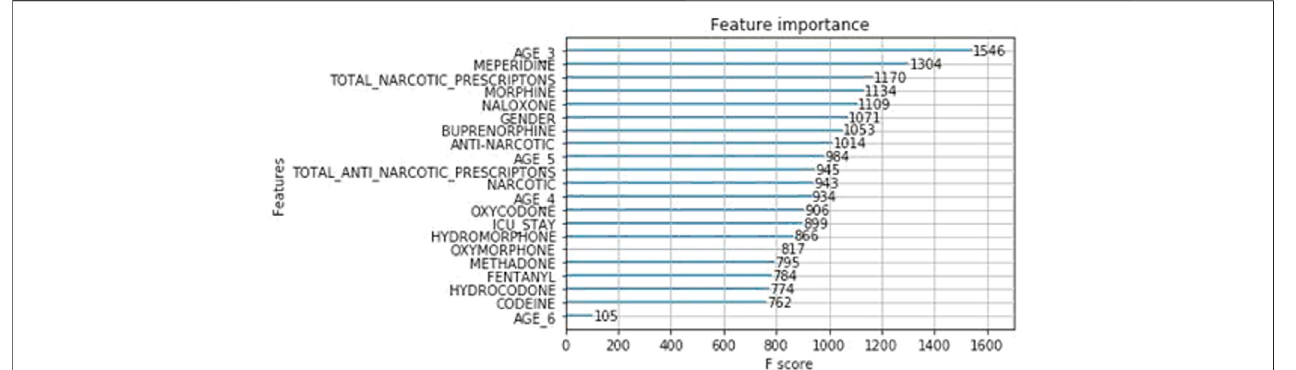
FIGURE 6 | Importance of